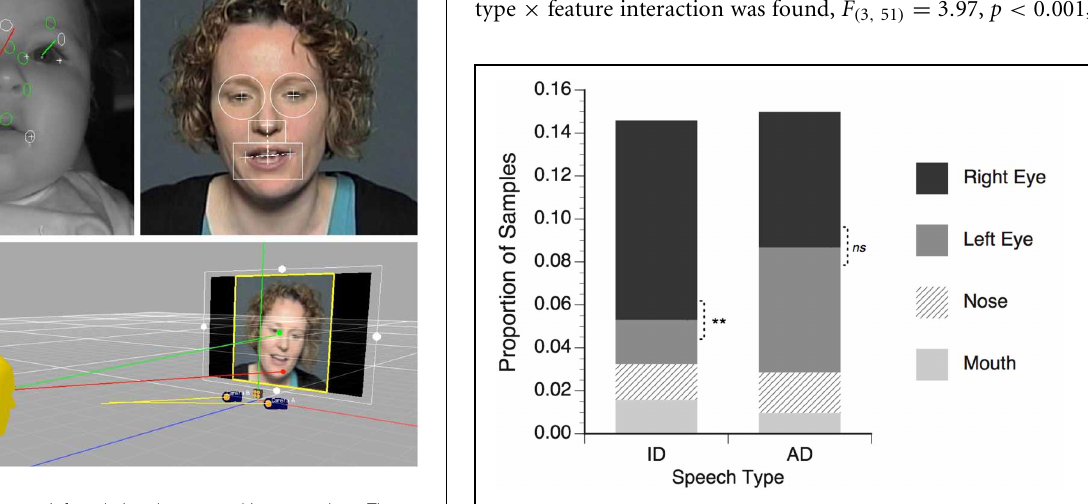
FIGURE 2 | Proportion of total eye tracker samples in which infants’ gaze fell within regions of interest around talker’s facial features. Right eye refers to the talker’s right eye, which appeared on the left side of the screen. Significance tests for differences between right and left eye; ∗∗ p < 0 . 01, ns =